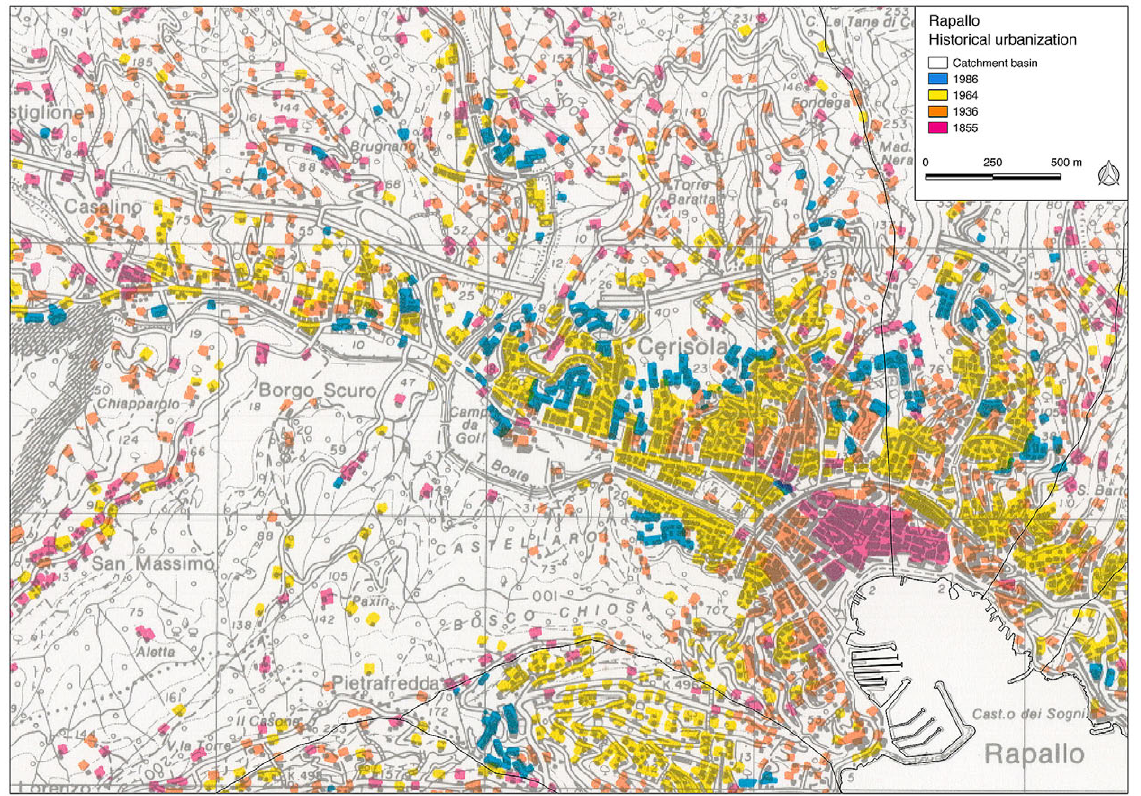
Fig. 10. Urban evolution map of Rapallo city from 1855 to 2000 (modified from Regione Liguria, 1986).